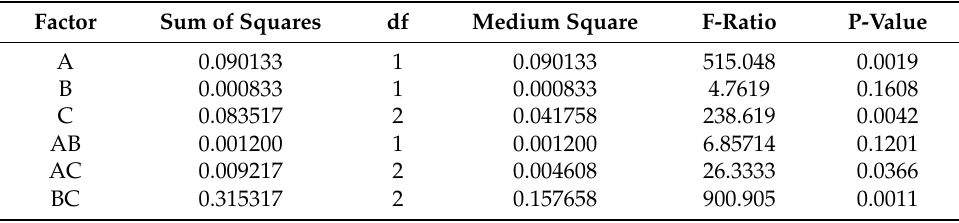
Table 4. Variance analysis summary for the PLA samples with Sg75_w as the optimization response and the factors printing speed (A), layer height (B) and sample thickness (C).